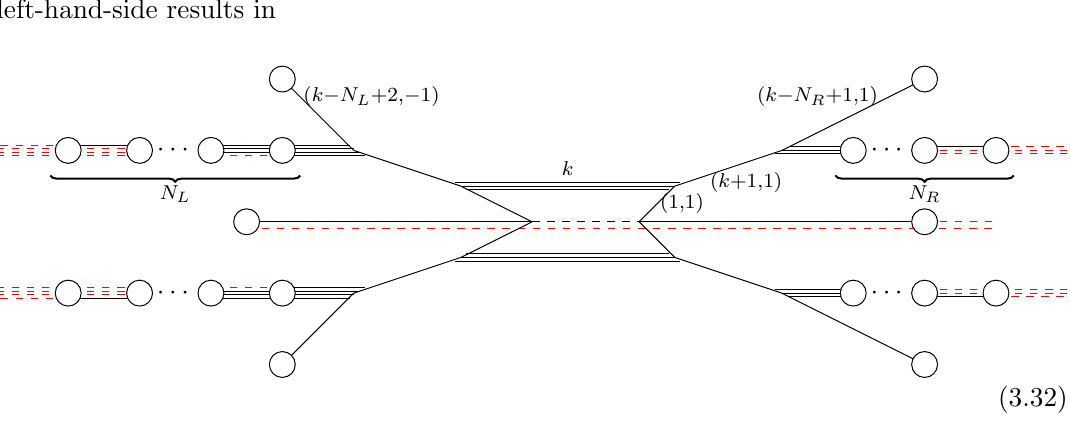
split along the orientifold. Then, moving only one half 7-brane through the 5-branes to